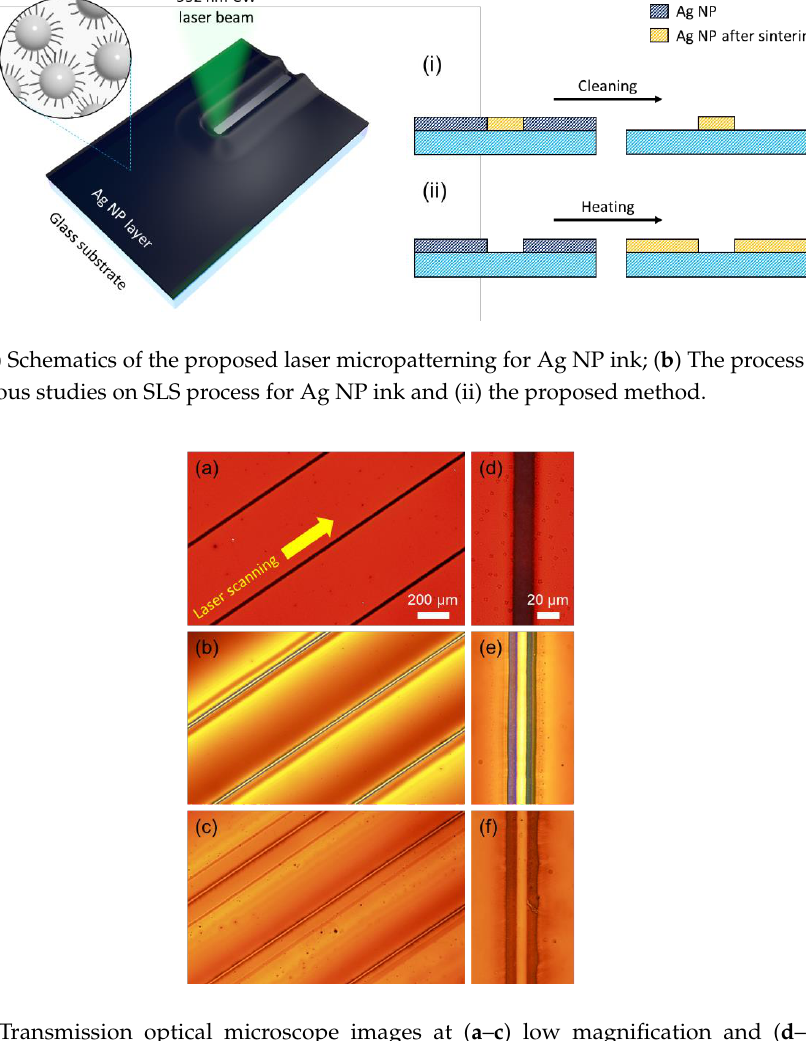
Figure 2. Transmission optical microscope images at ( a , b , c ) low magnification and ( d , e , f ) high magnification immediately after the laser scanning procedure on the Ag NP layer prepared at different spin-coating duration of ( a , d ) 1800 s ( b , e ) 300 s and ( c , f ) 60 s. The rotation speed has been fixed to be 500 rpm in every case.